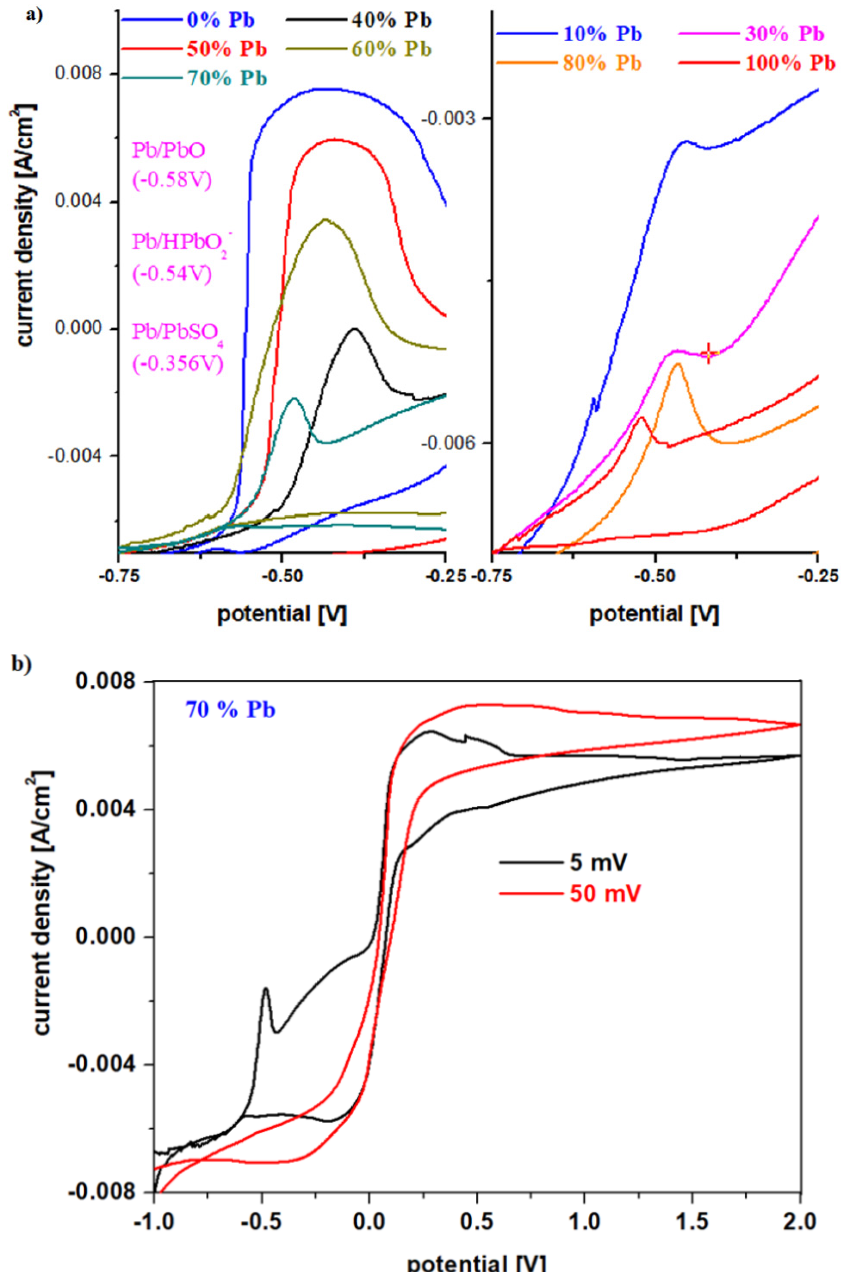
Figure 5. ( a ) First oxidation peak in cyclic voltammograms for the vitroceramic system with chemical formula of 15MnO 2 · 85[(100 − x)PbO 2 · xPb] where x = 0–100 mol% Pb in the potential range between − 0.75 and − 0.25 V; ( b ) Cyclic voltammograms for the vitroceramic system with chemical formula of 15MnO 2 · 85[(100 − x)PbO 2 · xPb] where x = 70 mol% Pb at different scan rates. The reduction peaks located at about 0.28 V, − 0.126 V, and − 0.345 V are well defined for the sample with x = 60 mol% Pb. This trend in redox processes suggests that thee redox couples do not produce completely different